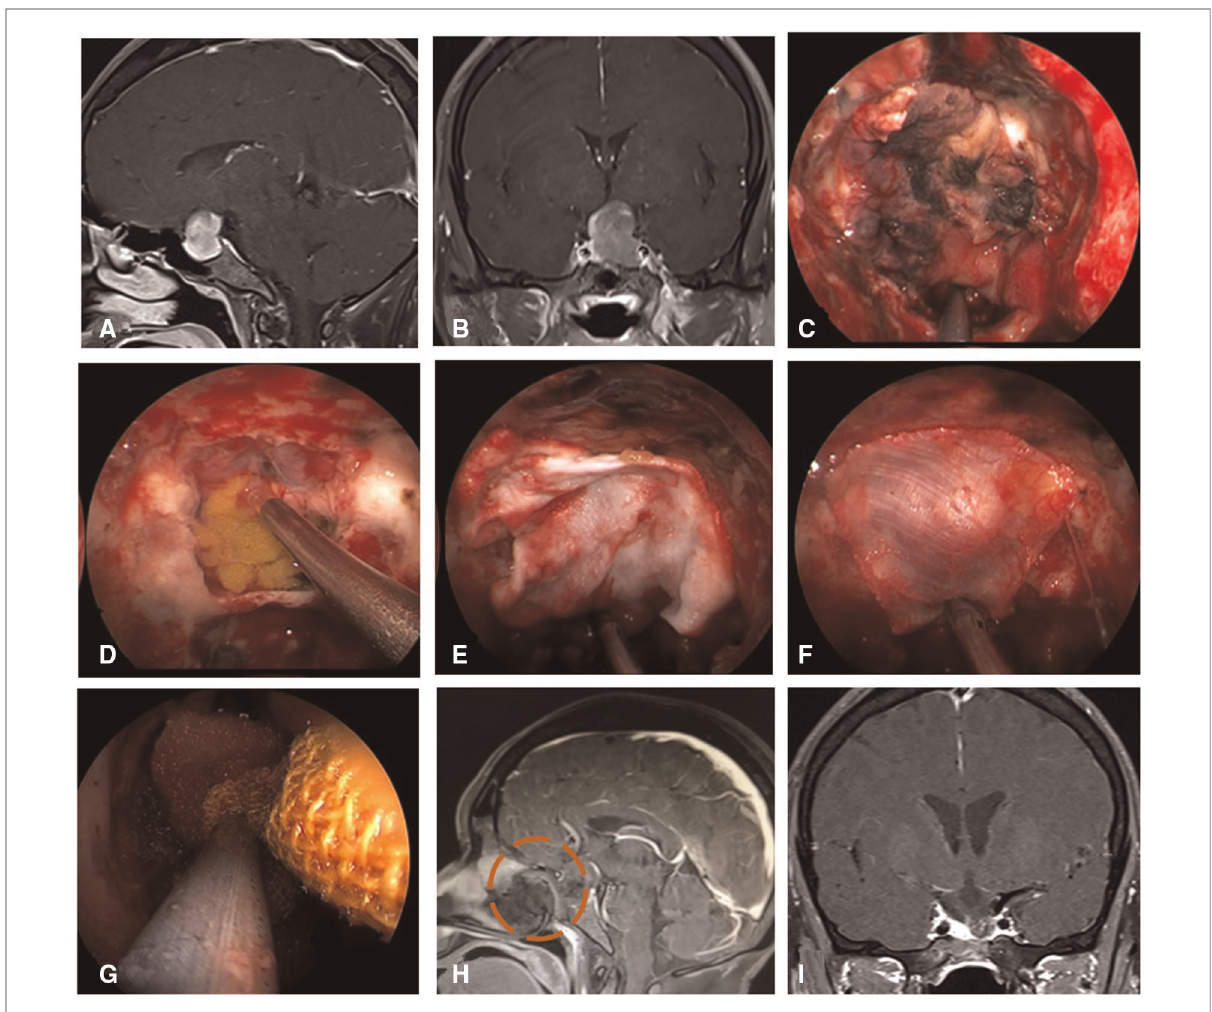
FIGURE 7 Repair process of patient with VP-NSF inactivation. ( A,B ) MRI enhanced in sellar region before operation and was considered pituitary adenoma. ( C ) VP-NSF inactivation observed on the endoscopy (black area). ( D ) Unraveling the arti fi cial inner dura. ( E ) Arti fi cial dura mater embedded between cellulite and dura mater. ( F ) Replacement of inactivated nasal septal mucosal fl ap using fascia lata. ( G ) Collagen sponge and biological protein glue was fi xed and then supported with iodoform gauze. ( H ) MRI enhancement at postoperative week 2 showed no signi fi cant enhancement of VP-NSF (circle). ( I ) Postoperative MRI enhancement in sellar region. VP-NSF, vascularized pedicle nasoseptal fl